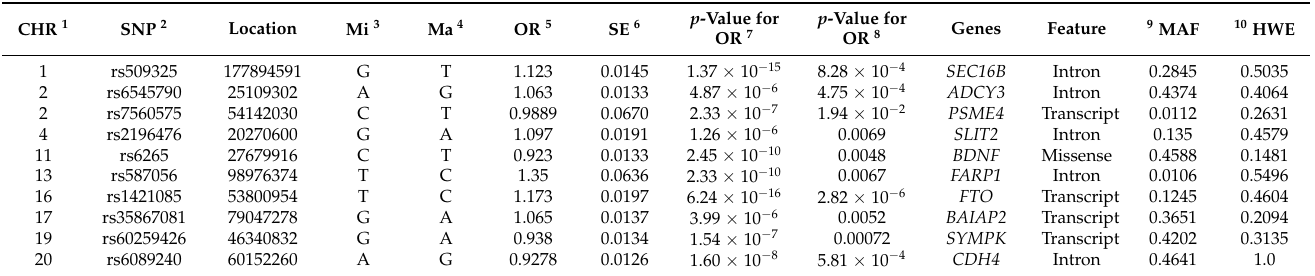
Table 5. The characteristics of the ten genetic variants of genes related to body fat mass in adults using the generalized multifactor dimensionality reduction